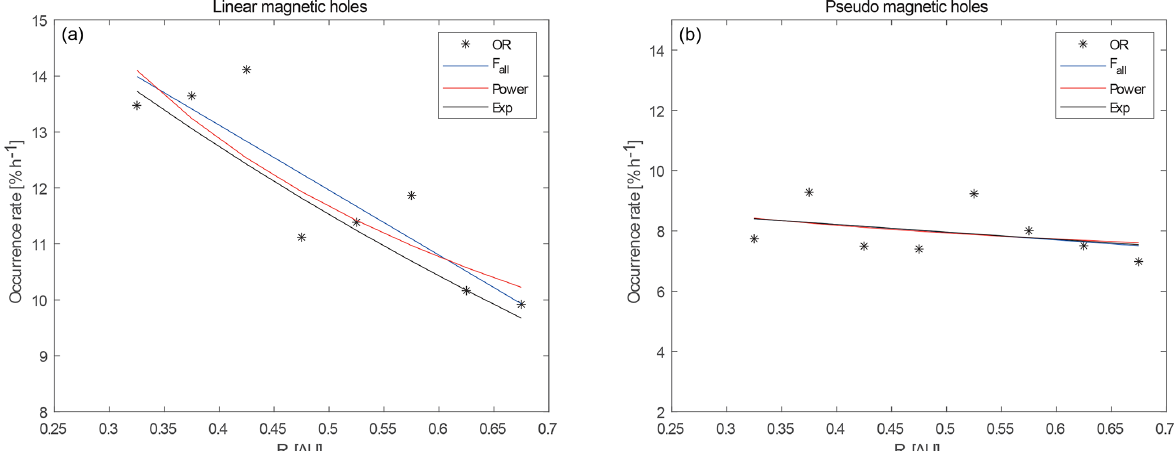
Figure 11. (a) The occurrence rate of LMHs as a function of R , to which various fits are made to all points except the last. A linear fit between Mercury and Venus ( F mv , green) and over all points ( F all , blue), a power law (Power, green), and an exponential (Exp, red). See the text for details. (b) The same fits for the occurrence rates of PMHs. See the text for details.